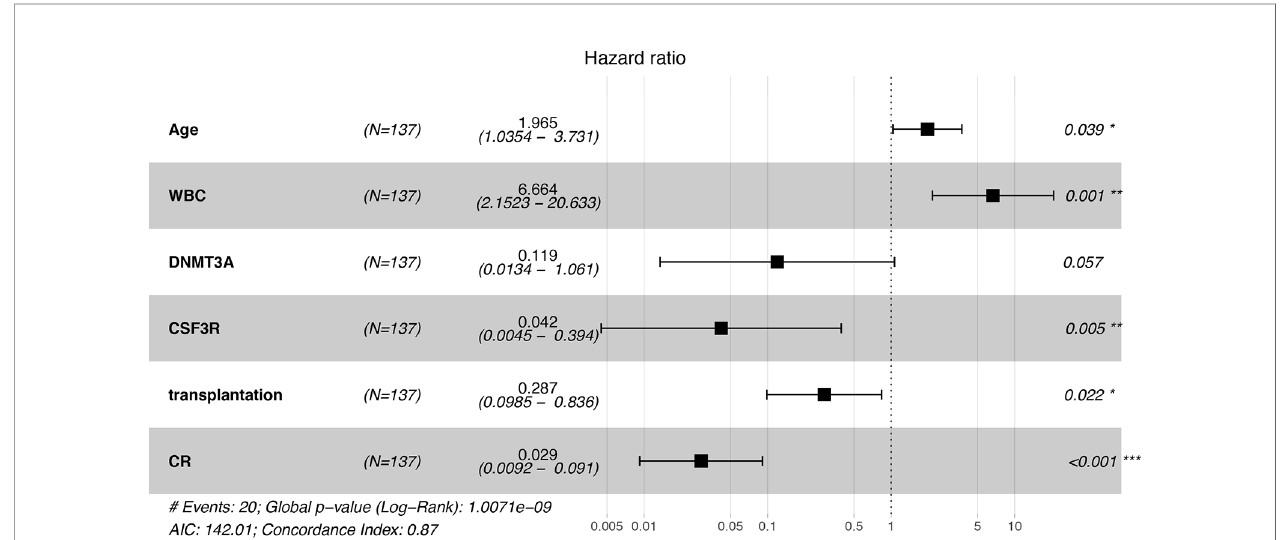
FIGURE 1 | Forest fi gure for AML patients with bi CEBPA mutations. Old age and high WBC count predicted lower overall survival, while CSF3R mutation, transplantation and the achievement of complete remission (CR) was associated with higher overall survival. *p < 0.05, **p < 0.01, ***p < 0.001.